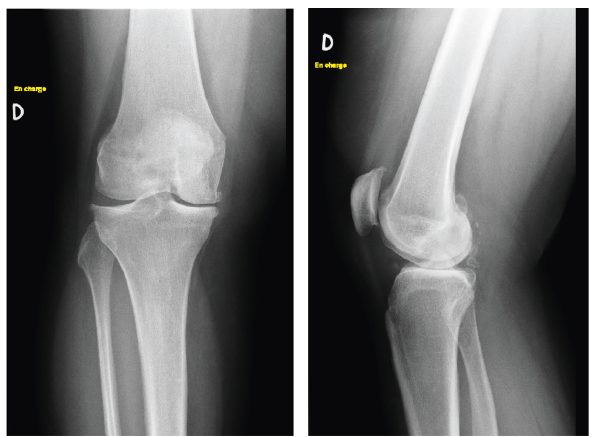
Figure 3: June 2009, 3 months after HTO, postoperative X-rays showing a slight pullout of the proximal screws. No fracture of the plate. No translation of the proximal fragment of the HTO.